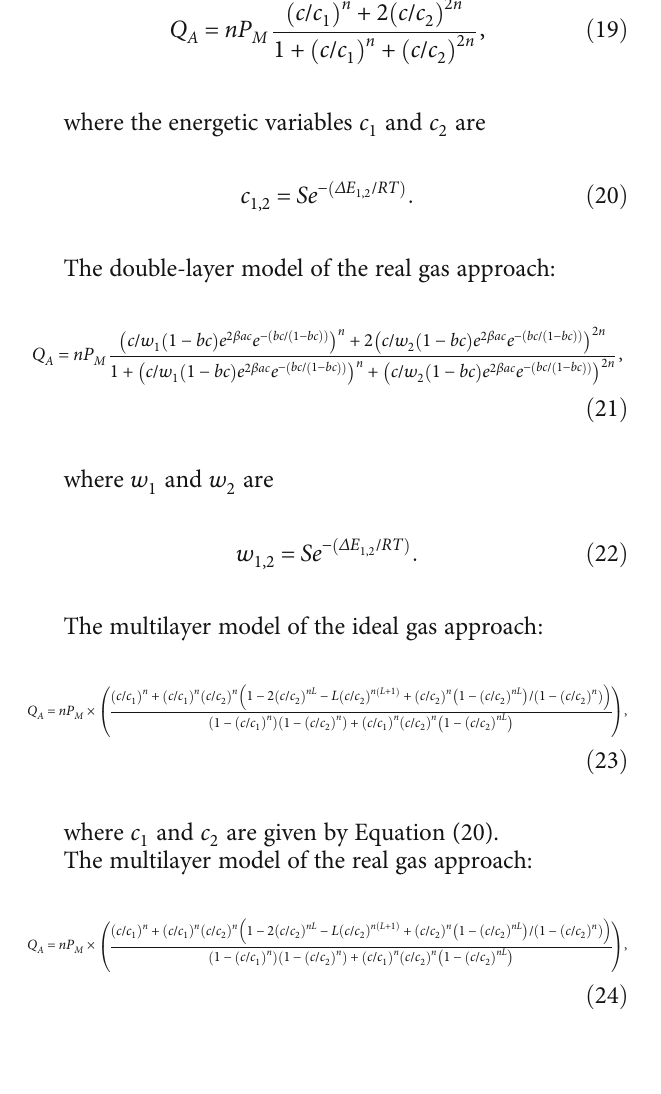
Figure 5: Illustration of the monolayer adsorption of AlCl H TPP and H 2 2